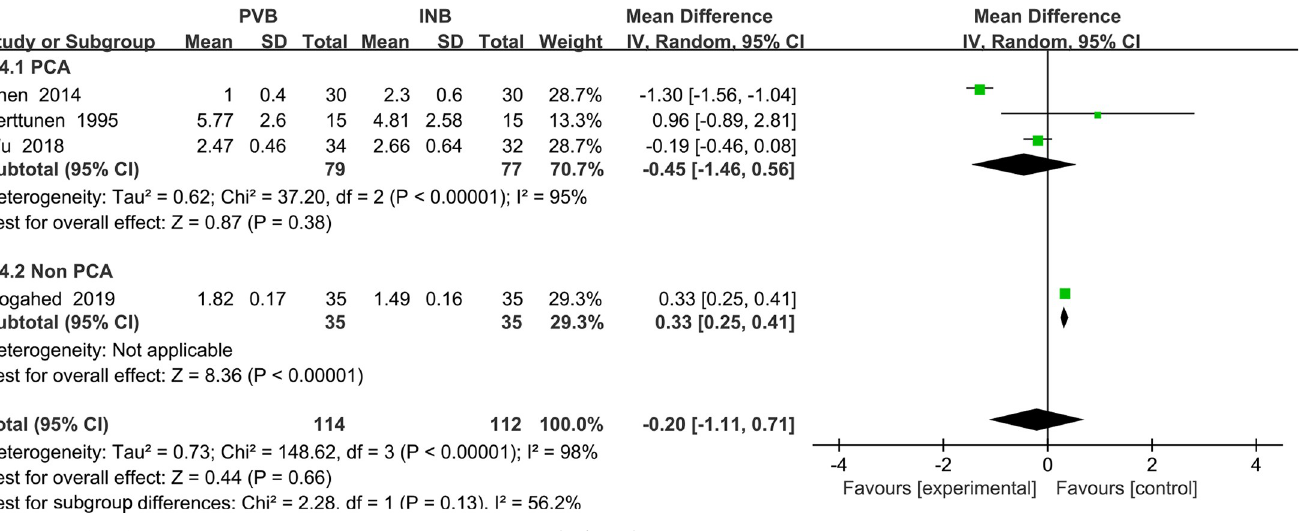
Fig 3. Forest plot of comparison: PVB VS INB. Outcome: VAS at rest at the first 1 h.